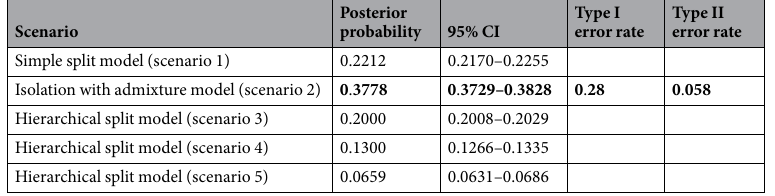
Table 3. Posterior probability and 95% confidence intervals (CI) using a logistic regression in the Approximate Bayesian Computation (ABC) analysis for five scenarios of Psittacanthus calyculatus / schiedeanus divergence and hybridization. Type I and Type II error rates were estimated for scenario